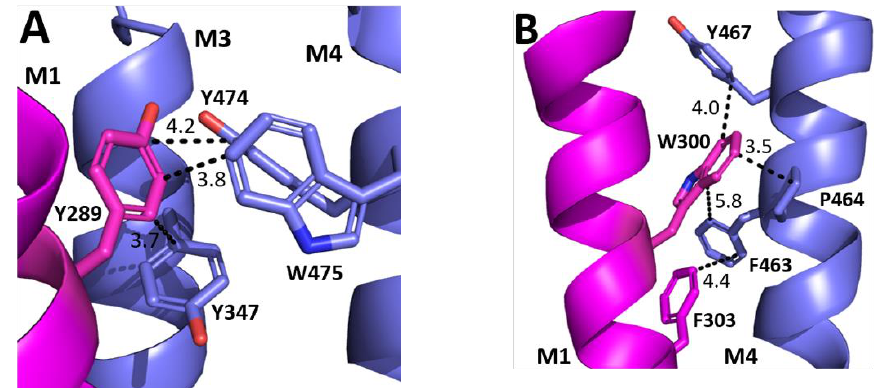
Figure 5. Possible M1 helix interactions with M3 and M4 helices. ( A ) The interface between the M1 (magenta) and M3 and M4 helices (blue) close to Y289. ( B ) The interface between the M1 (magenta) and the M4 helix (blue) close to W300 and F303.